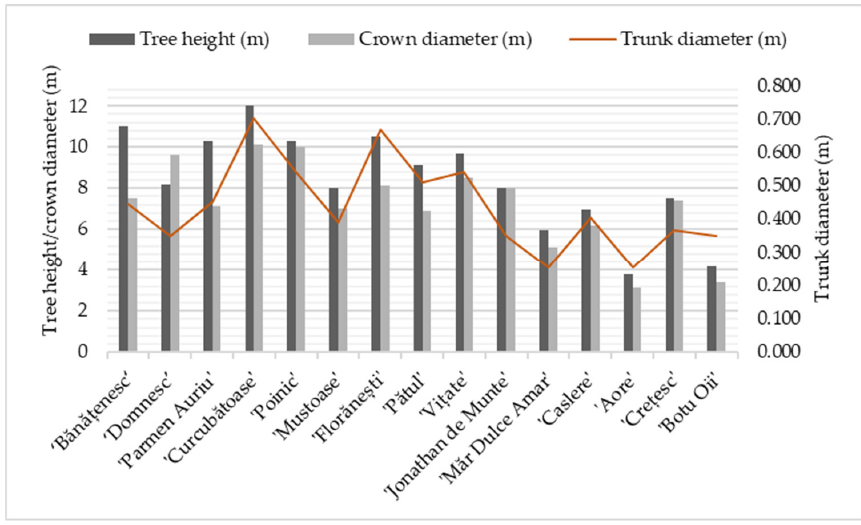
Figure 1. Growth vigor of the investigated apple varieties before grafting. After their grafting and cultivation in the orchard, the same varieties can be divided as follows (Figure 2): vigorous—‘Curcubătoase’, ‘Poinic’, ‘Mustoase’, ‘Florănești’ and ‘Aore’; with medium vigor—‘Domnesc’, ‘Pătul’, ‘Bănățenesc’, ‘Crețesc’ and ‘Jonathan de Munte’; and with low vigor—‘Botu Oii’, ‘Caslere’ ‘Vițate’, ‘Măr Dulce Amar’ and ‘Parmen Auriu’.